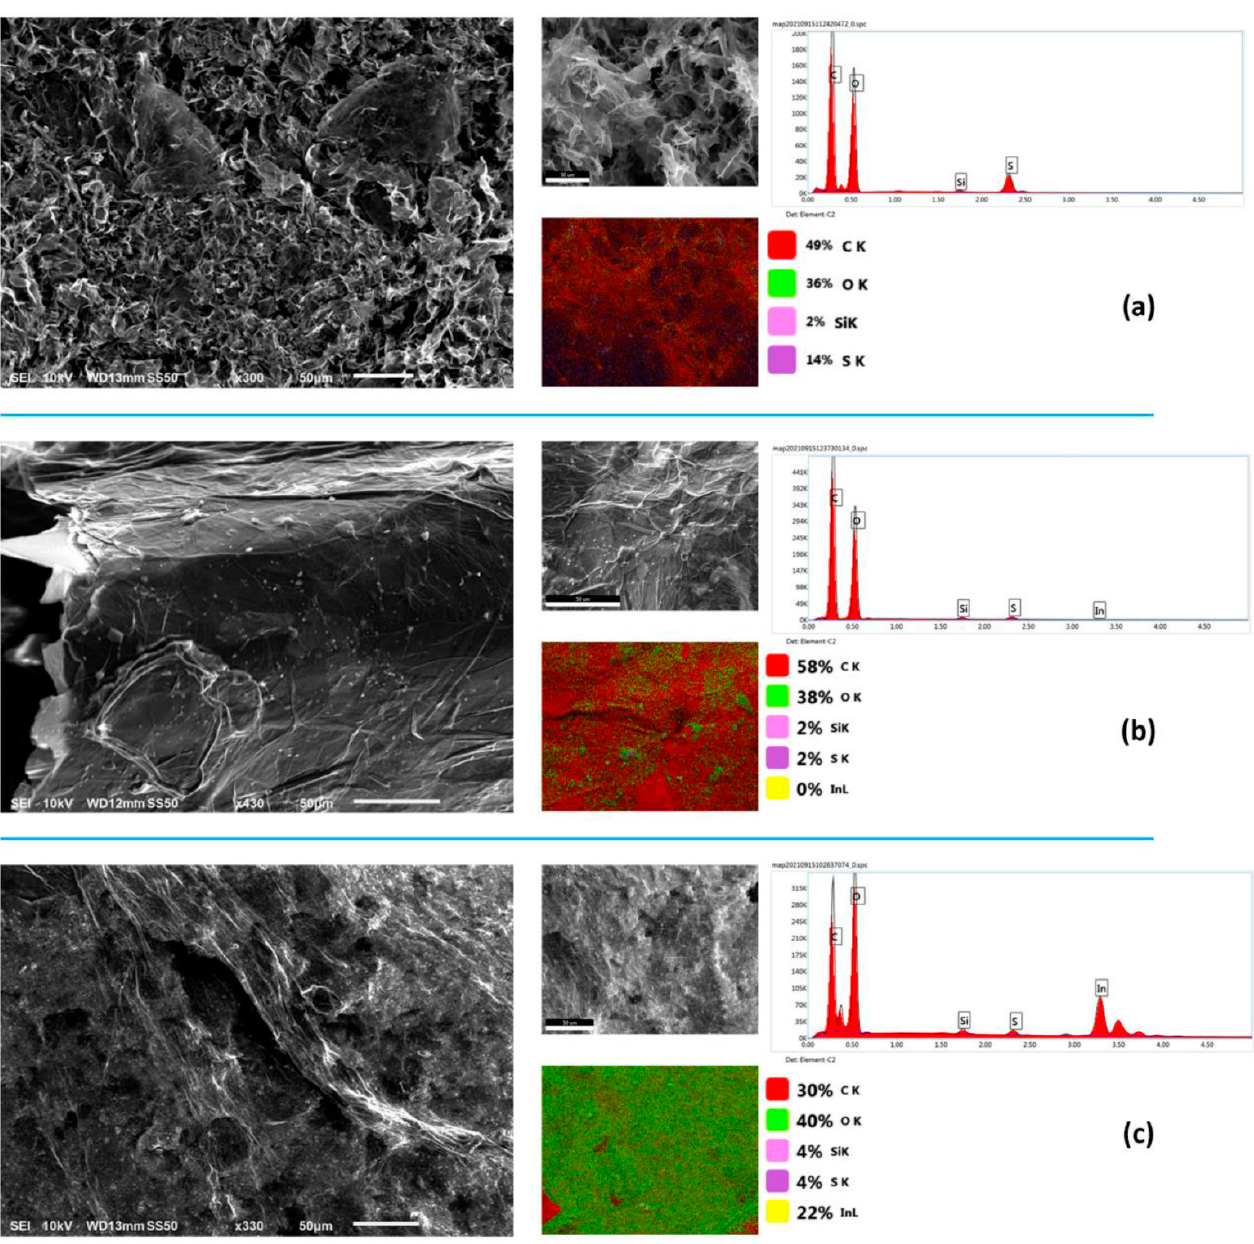
Figure 4. SEM and EDS results of samples separated in 3 rows: ( a ) graphene oxide, ( b ) developed reduced graphene oxide and ( c ) In 2 O 3 functionalised graphene. All scale bars are 50 µm.